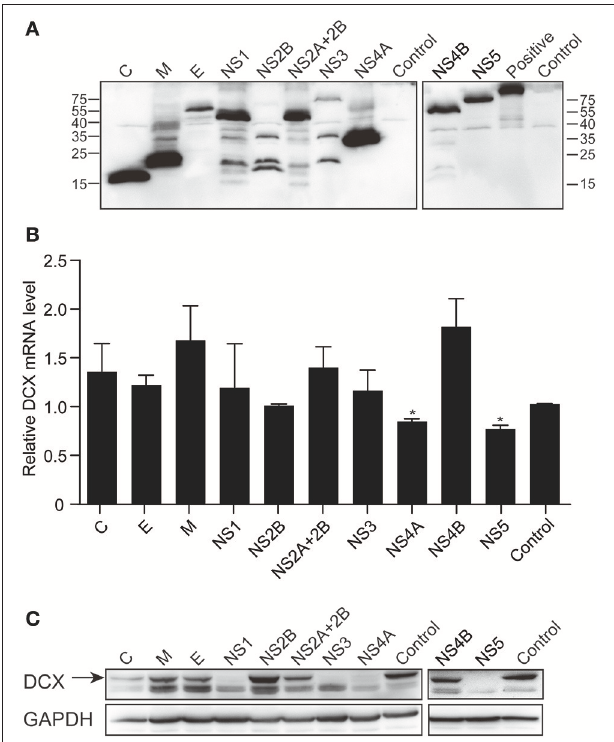
FIGURE 8 | ZIKV NS4A and NS5 are involved in regulation of DCX mRNA and protein levels in NPCs. (A) Viral proteins expression. Cell lysates from lentivirus-transduced NPCs expressing ZIKV C, M, E, NS1, NS2B, NS2A + 2B, NS3, NS4A, NS4B, and NS5 were prepared. FLAG-tagged viral proteins were detected by immunoblotting assay using anti-FLAG antibody. A FLAG-tagged beta-catenin protein (92 kDa) was using as positive control. (B) DCX mRNA level. NPCs were transduced with lentiviruses to express ZIKV viral proteins. Total RNA was extracted, reverse-transcribed and mRNA levels were assessed by qRT-PCR. Relative DCX mRNA levels were normalized to GAPDH mRNA levels in each sample and indicated as fold changes relative to control. * p < 0.05. (C) DCX protein level. Cell lysates from lentivirus-transduced NPCs were prepared. DCX protein levels were determined by immunoblotting assay. DCX band was indicated by an